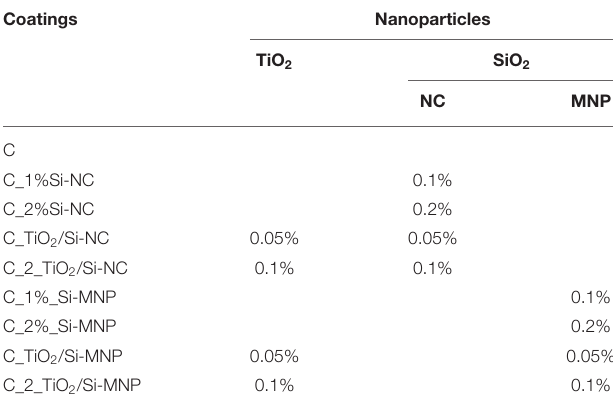
TABLE 1 | Contents of nanoparticles, expressed in percent volume of TEOS, in the multifunctional coatings. Coatings Nanoparticles TiO